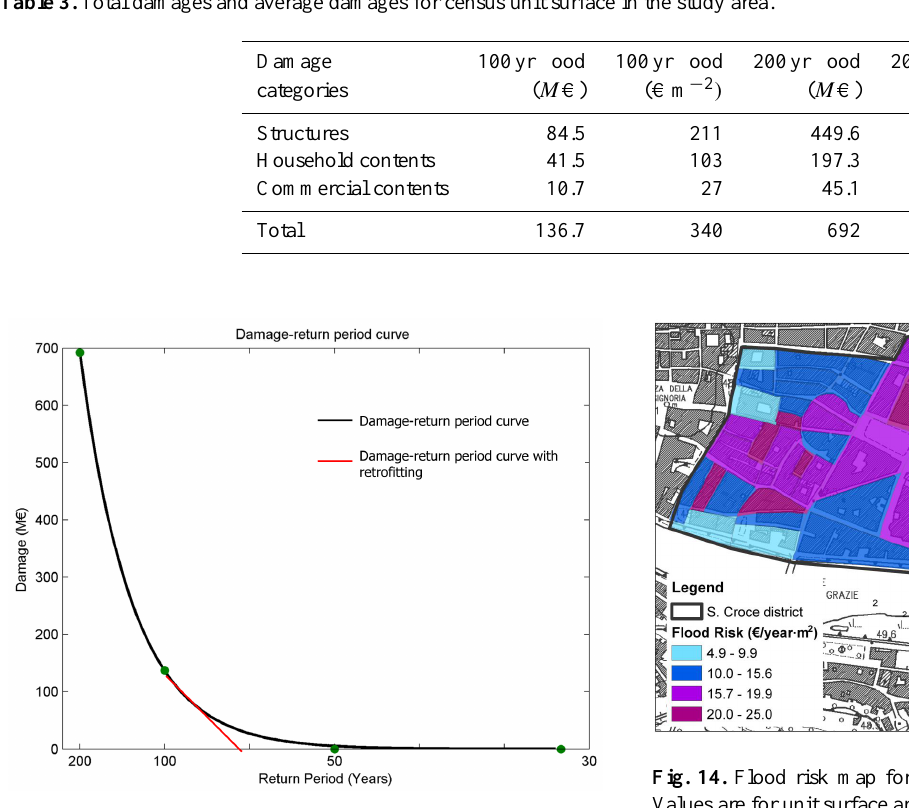
Figure 13. Damage-return period curves for the S. Croce district, with and without building 2 Fig. 13. Damage–return period curves for the St. Croce district, with and without building retrofitting. retrofitting. 3